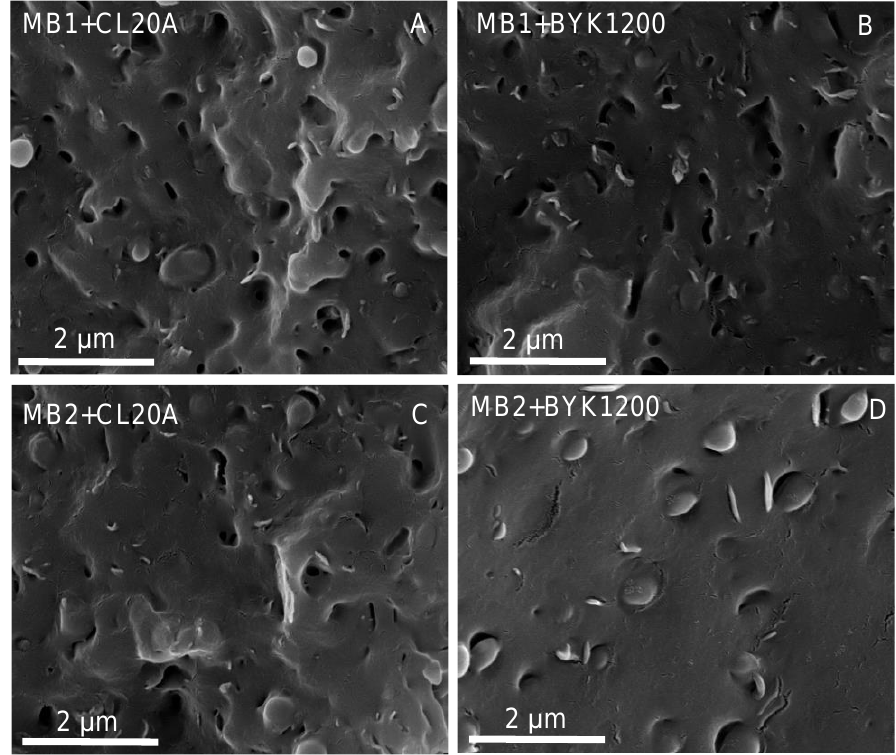
Figure 1. SEM micrographs of ( A , B ) MB1- and ( B , C ) MB2-based bionanocomposites.